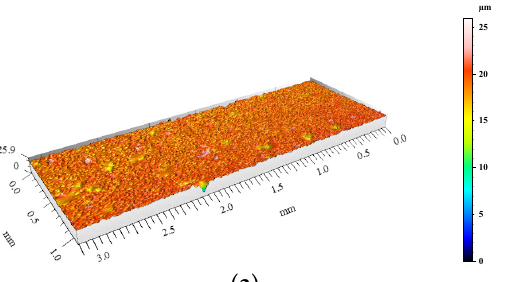
Figure 10. View of AlSi12/SiC p composite surface geometry: ( a ) before and ( b ) after dry friction test.